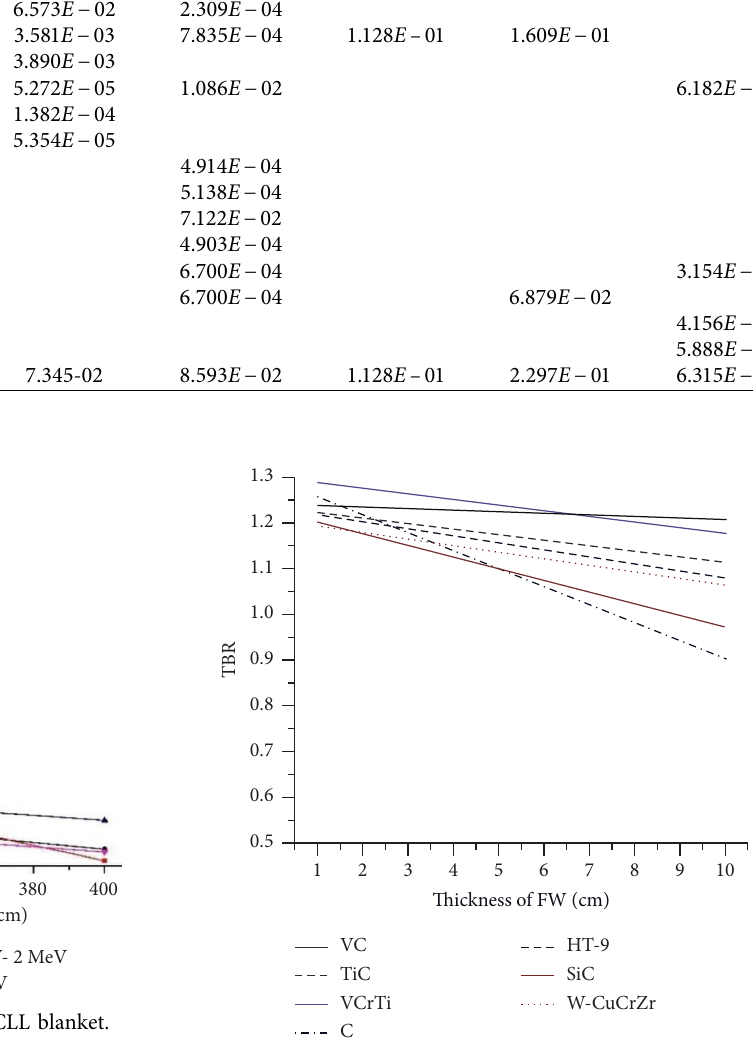
Figure 9: Diferent thicknesses of FW calculation afected in tri- tium breeding ratio (TBR) for variation of candidate FW